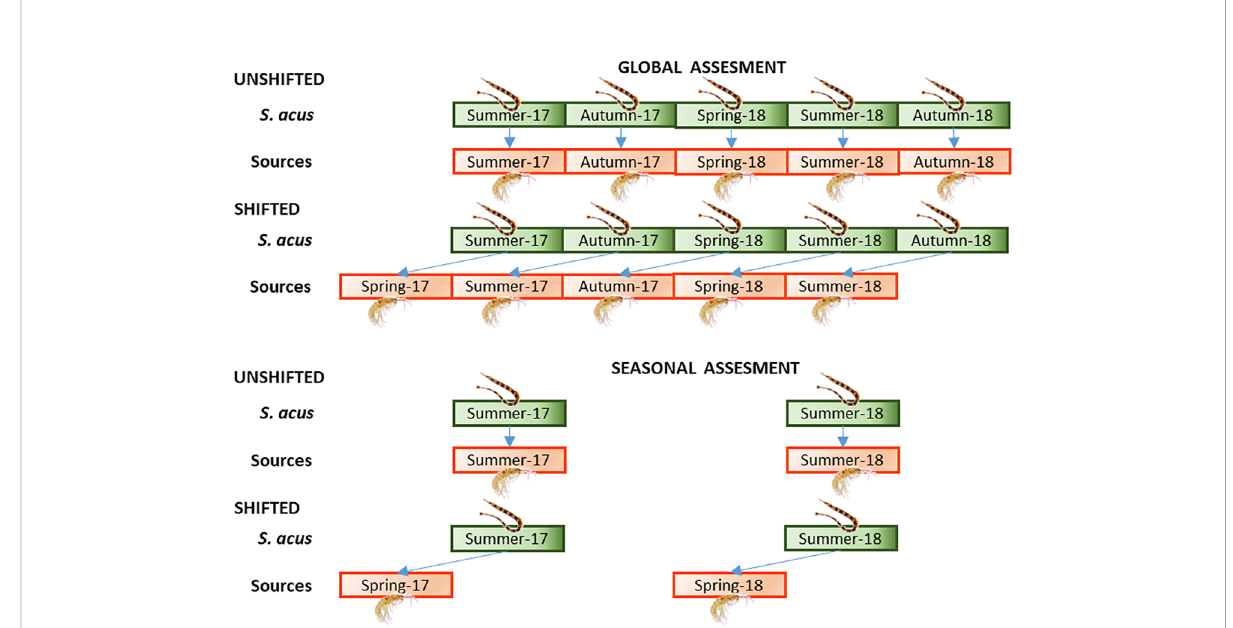
FIGURE 2 Approaches followed for the assessment of the dietary regime in S. acus . Global assessment – specimens collected for the entire monitoring period (summer and autumn in 2017 and spring, summer and autumn in 2018). Seasonal assessment – specimens collected in summer (2017 and 2018). Treatments: average isotopic values of potential sources sampled (A) concomitantly with consumers (Unshifted), or (B) in the previous season of consumer sampling